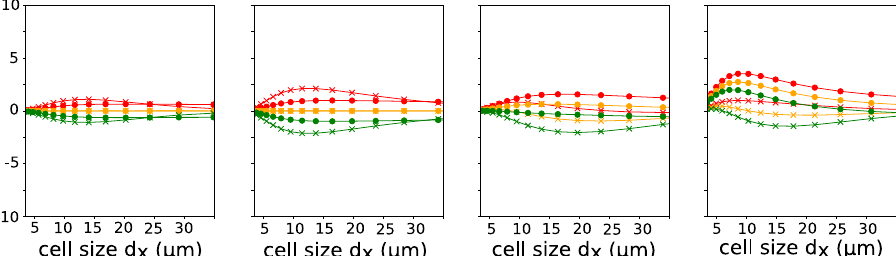
Fig 5. Response of the two cascade systems, MMC and PC, for different cell shapes to a variation of the signal gradient. ( A ) Spatial concentration profile of (cid:22) P on the cell membrane as well as along a slice through the cell in 3 response to a homogeneous input signal P 0 (cid:17) 100 n M μm .The spherical cell has a size of R cell = 2.5 μm with a nucleus of radius R nuc = 1 μm . All cell shapes have the same cell volume and contain a spherical nucleus of the same size. ( B ) Simulations for varying cell size measured as diameter d x in x-direction and three different signal slopes P slope ¼ (cid:0) 0 : 03 m m (cid:0) 1 (green), 0 (orange), 0.03 μm −1 (red) were performed. The gradient grad 0 (cid:22) P ð ~ x Þ (cid:0) (cid:22) P ð ~ x ÞÞ = j ~ x (cid:0) ~ x j was plotted. Here, ~ x and ~ x are the extreme points x -direction on the ≔ ð (cid:22) P 3 3 3 front back front back front back cell membrane or nucleus. In ( C ) and ( D ), the PC cascades was simulated for the same setup as in ( A ),( B ).The parameters used were α 1 = α 2 = α 3 = 1 s − 1 , β 1 = β 2 = β 3 = 1 s − 1 , γ = 0.5 μm s − 1 , D mem = 0.03 μm 2 s − 1 and D cyt = 3.0 μm 2 s − 1